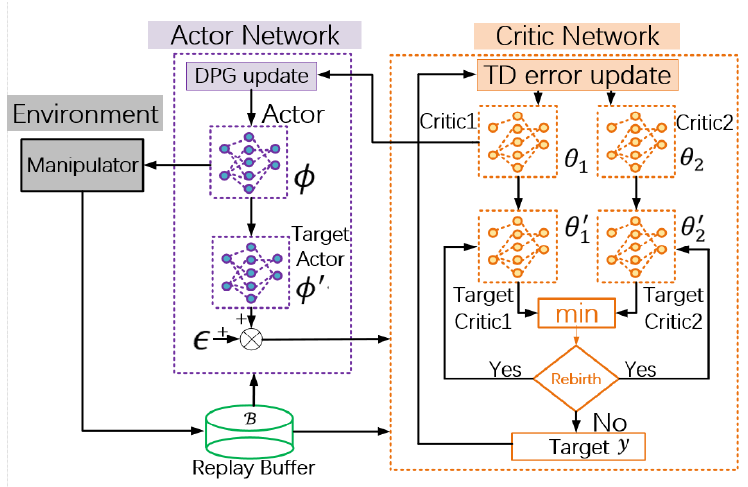
Figure 3. Twin Delayed Deep Deterministic Policy Gradient with Rebirth Mechanism (RTD3) network structure